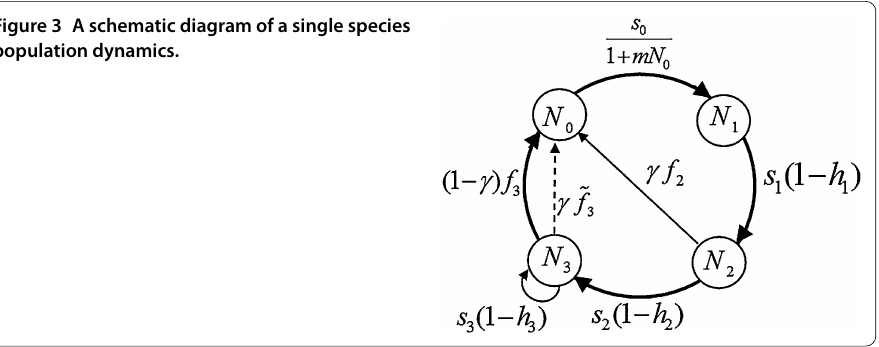
Figure 3 A schematic diagram of a single species population dynamics.